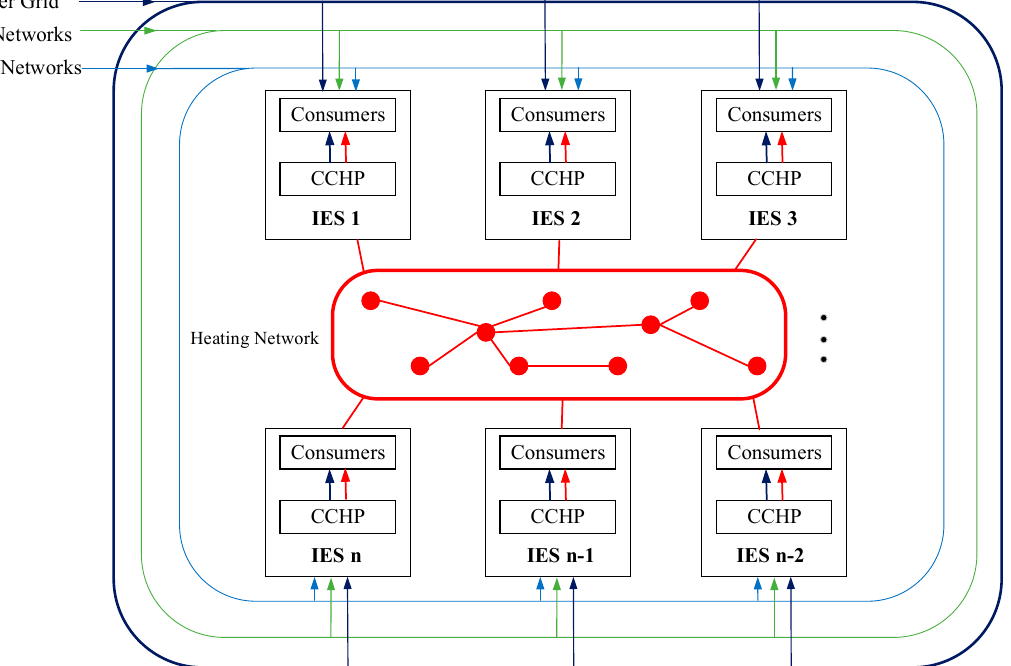
Figure 3. Coupling structure of multi-district IES and heating networks.